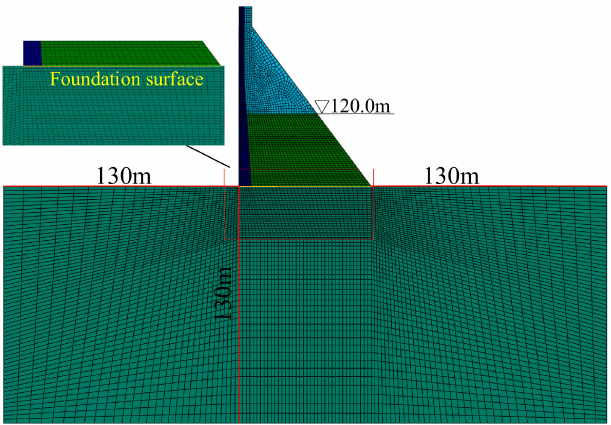
Figure 13. Finite element computational